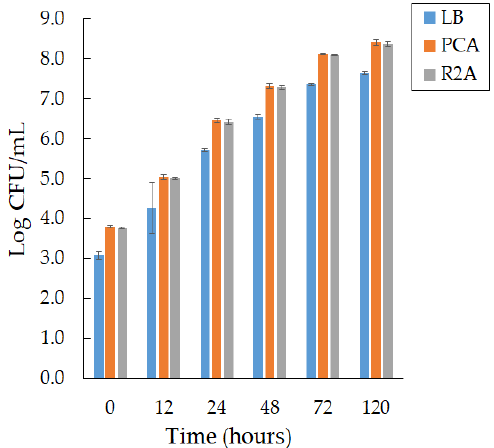
Figure 1. The growth of the Janthinobacterium sp. SLB01 strain at 22 °C on the different media (LB agar, PCA, and R 2A). Results are reported as mean values of three independent experiments per- formed.